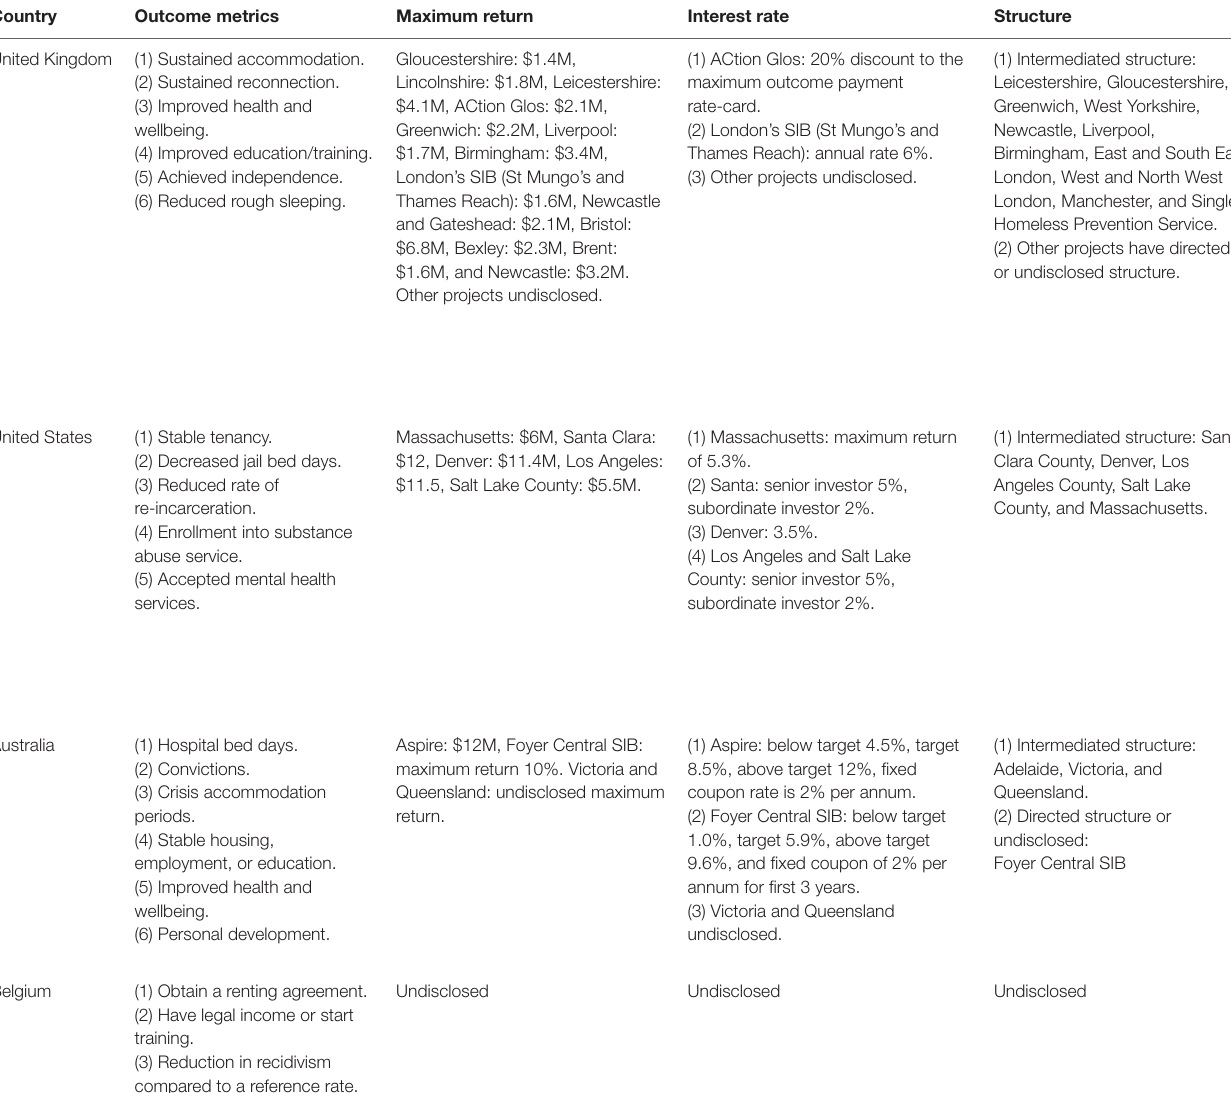
TABLE 4 | Financial terms of all SIBs for homelessness. Country Outcome metrics Maximum return Interest rate